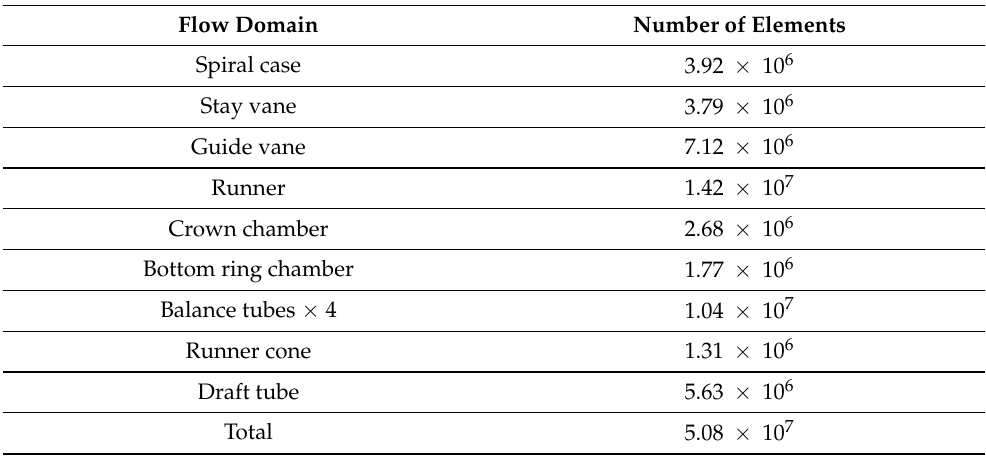
Table 3. Number of elements in the flow